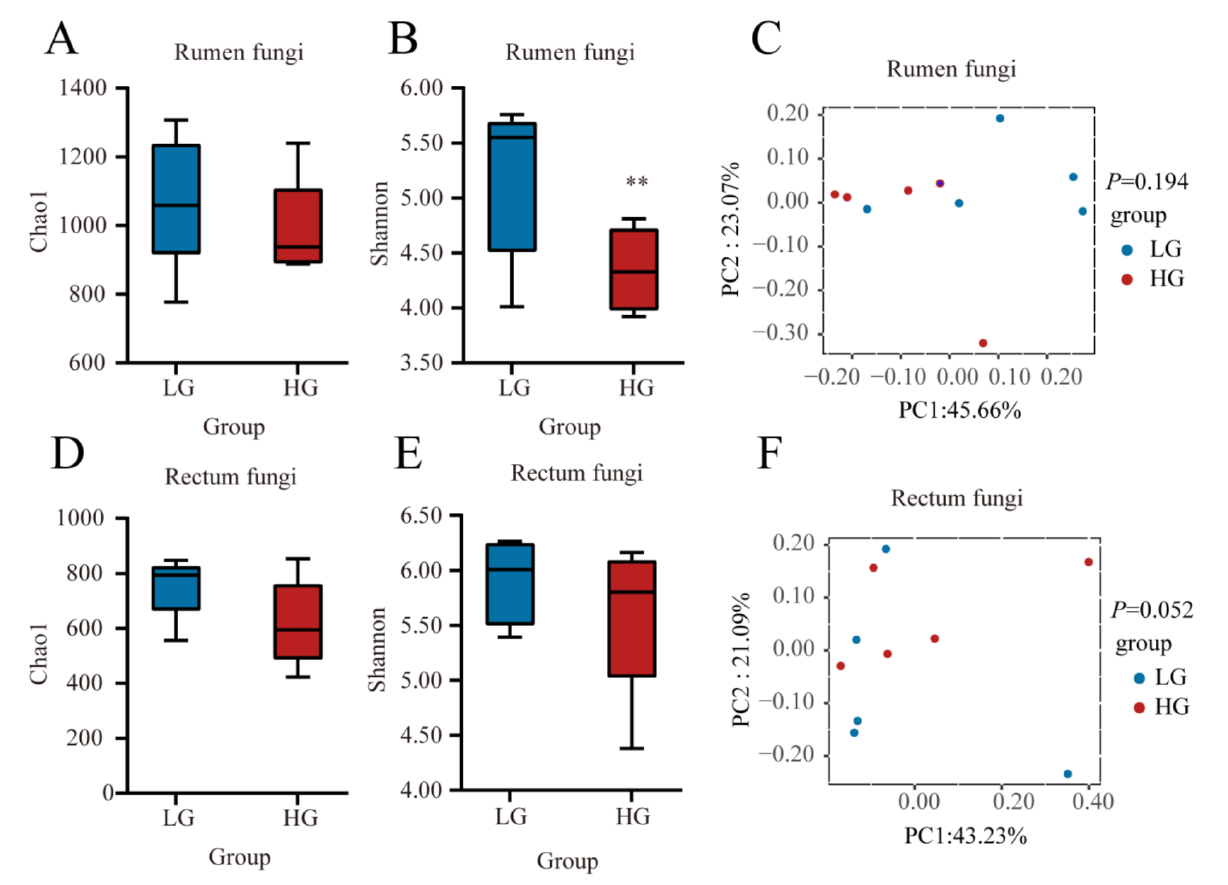
Figure 4. Fungal communities and differences between the five lambs with the lower average daily gain (LG) and the five lambs with the higher average daily gain (HG) in the gastrointestinal tract at 90 days of age. ( A ) Chao 1 index and ( B ) Shannon index in the rumen. ( C ) Principal coordinate analysis (PCoA) of fungal Bray-Curtis distance in LG and HG groups in the rumen. ( D ) Chao 1 index and ( E ) Shannon index in the rectum. ( F ) PCoA of fungal Bray-Curtis distance in LG and HG groups in the rectum. The whiskers represent the minimum and maximum values. ** p < 0.05.